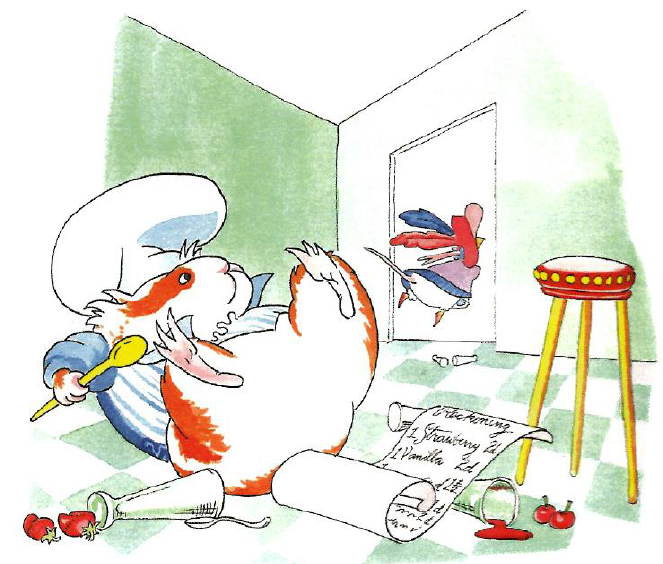
Figure 3. McMaster’s illustration for The Beautifull Cassandra (Austen 2021), p. 11.